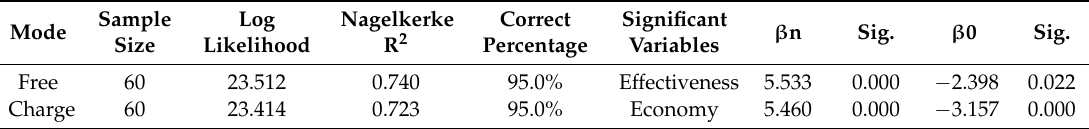
Table 10. Results of logistic regression under two